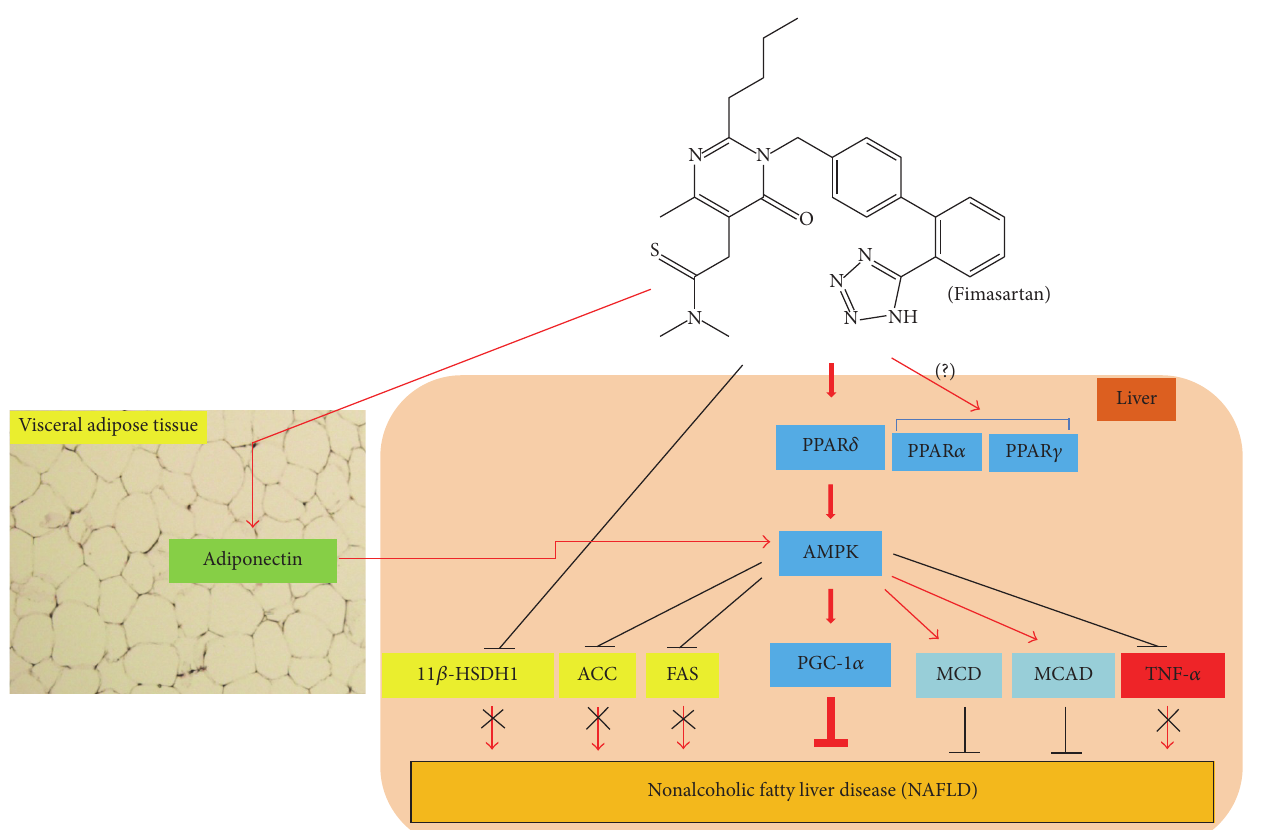
Figure 8: Schematic illustration for hypothetical reaction mechanisms of fimasartan in nonalcoholic fatty liver disease. Amelioration of nonalcoholic fatty liver disease by fimasartan is mainly accomplished with catabolic activation such as the sequential regulation of PPAR 𝛿 → AMPK → PGC-1 𝛼 . In addition, Aster glehni lowers triglyceride accumulation in liver by inhibiting 11 𝛽 -HSDH1, ACC, FAS, and TNF- 𝛼 ; also, its effect is additionally exerted by activating adiponectin, MCD, and MCAD. Meaning of symbols: arrow means activation, up and horizontal line means inhibition, and X means